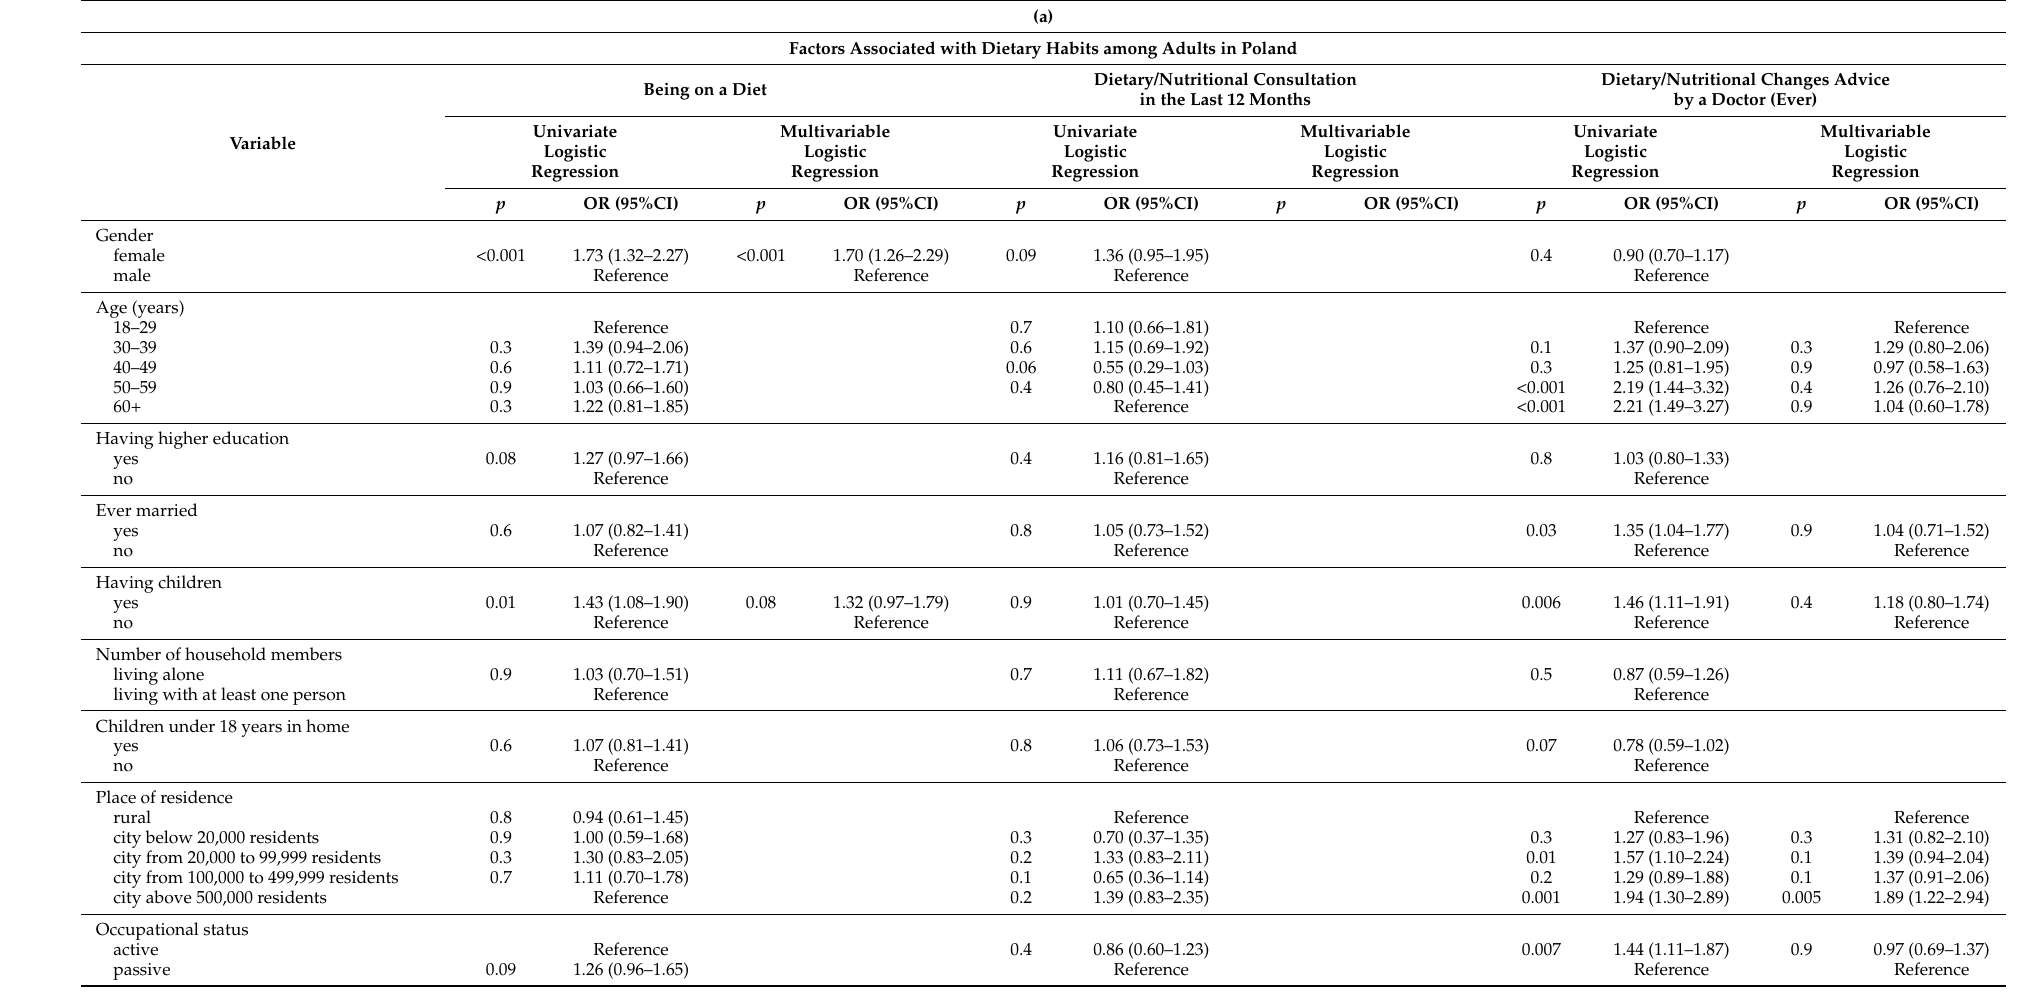
Table 4. Factors associated with dietary habits among adults in Poland (n = 1070). (a) Factors Associated with Dietary Habits among Adults in